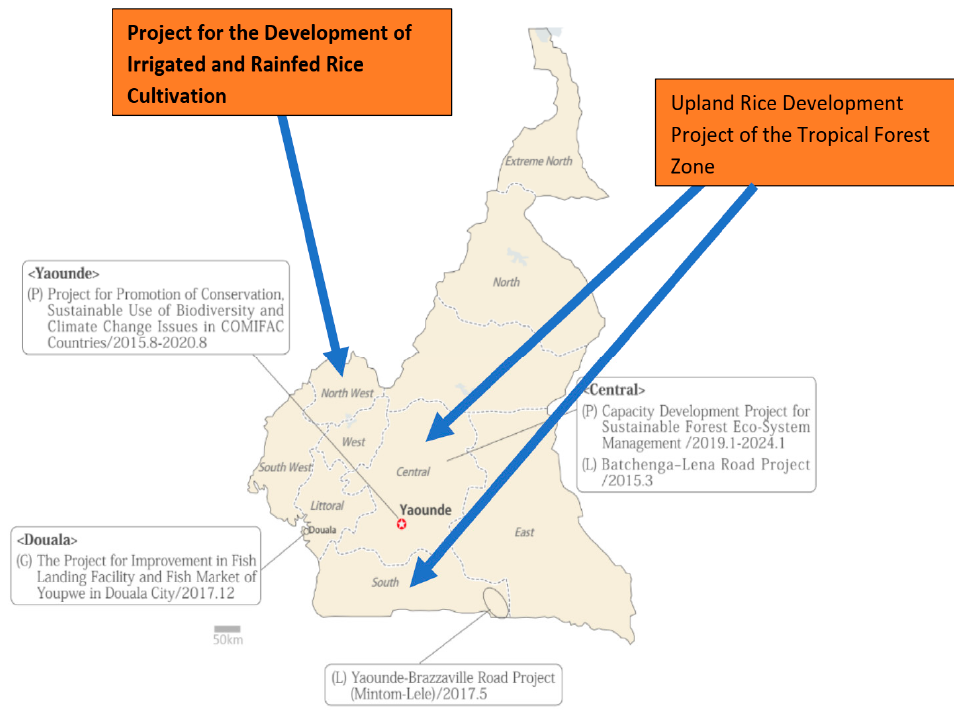
Figure 2. Map of Cameroon showing JICA projects.